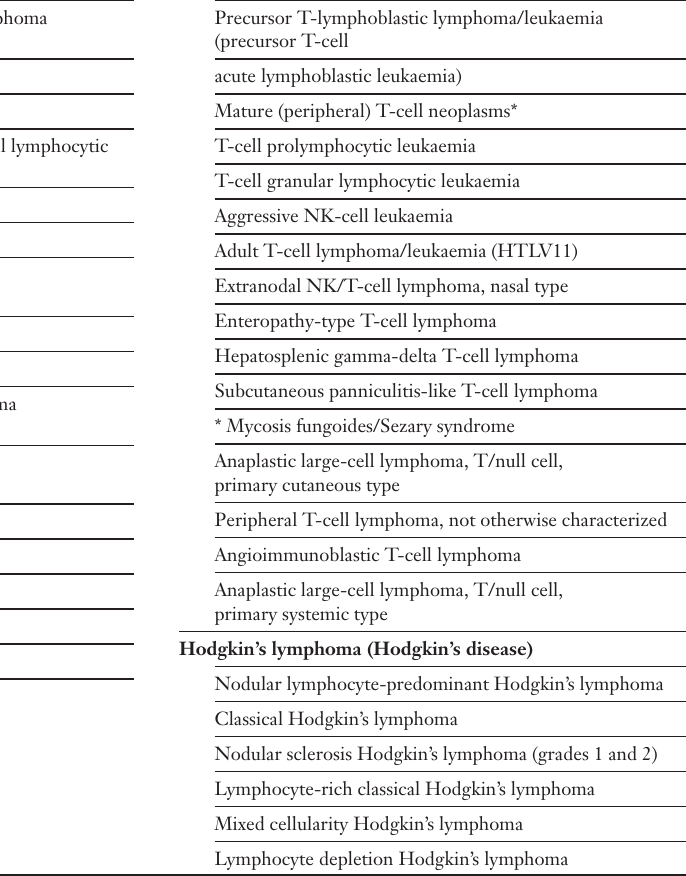
Proposed WHO clas- sification of lym- phoid